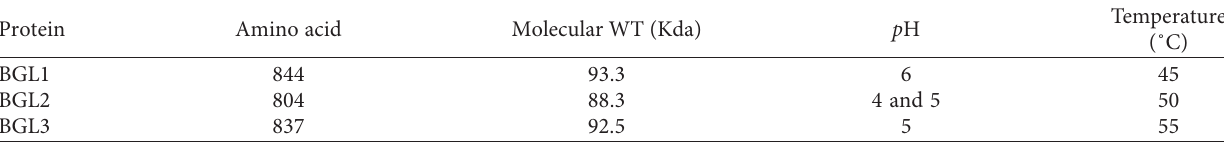
Figure 2: A phylogenetic tree derived from amino acid sequence analysis showing relationships of three forms of β -glucosidase from Clavispora NRRL Y-50464 (BGL1, BGL2, and BGL3) with other microbial BGLs from Aspergillus Niger (AnBGL1), Trichoderma harzianum (ThBGL2), Trichoderma reesei (TrBGL), Kluyveromyces marxianus (KmBGL1), Myceliophthora thermophila (MtBGL3a), Neurospora crassa (Ncbgl1, Ncbgl2, Ncbgl4, and Ncbgl6), and Bacillus polymyxa (BpBGLb) [41]. Table 2: Protein characterization of partially purified β -glucosidases from Clavispora NRRL Y-50464 and their optimal pH and temperature as measured by specific enzyme activity.